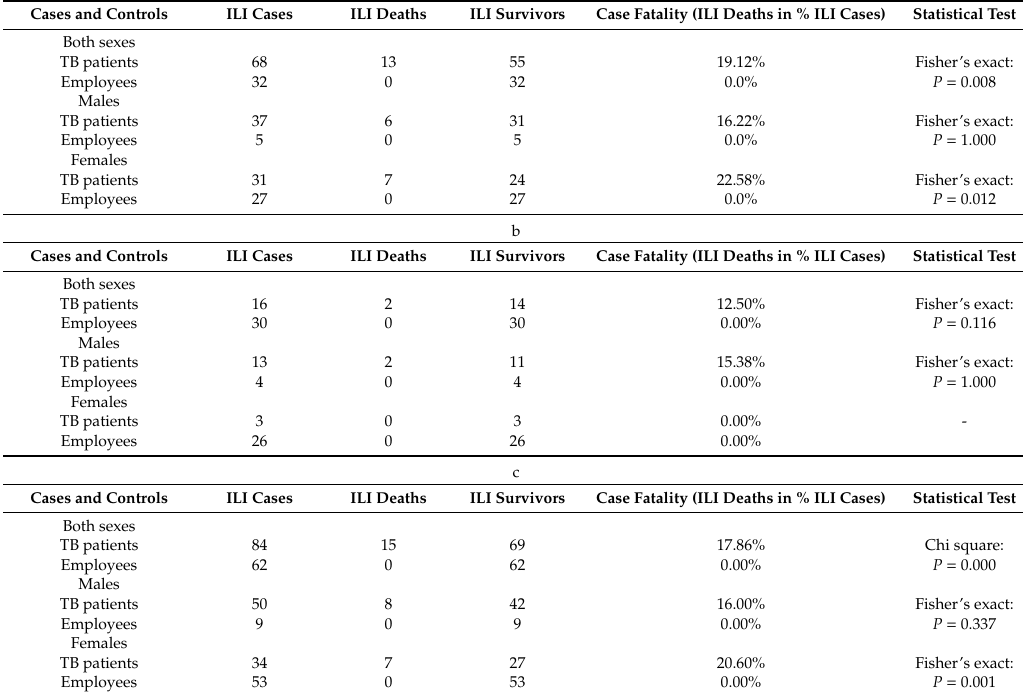
Table 4. (a) Cross tabulation of tuberculosis and conditional risk of ILI death among ILI cases at Lyster sanatorium by sex and both sexes combined during the 1918 fall wave; (b) Cross tabulation of tuberculosis and conditional risk of ILI death among ILI cases at Landeskogen sanatorium by sex and both sexes combined during the 1918 fall wave; (c) Cross tabulation of tuberculosis and conditional risk of ILI death among ILI cases at both sanatoriums by sex and both sexes combined during the 1918 fall